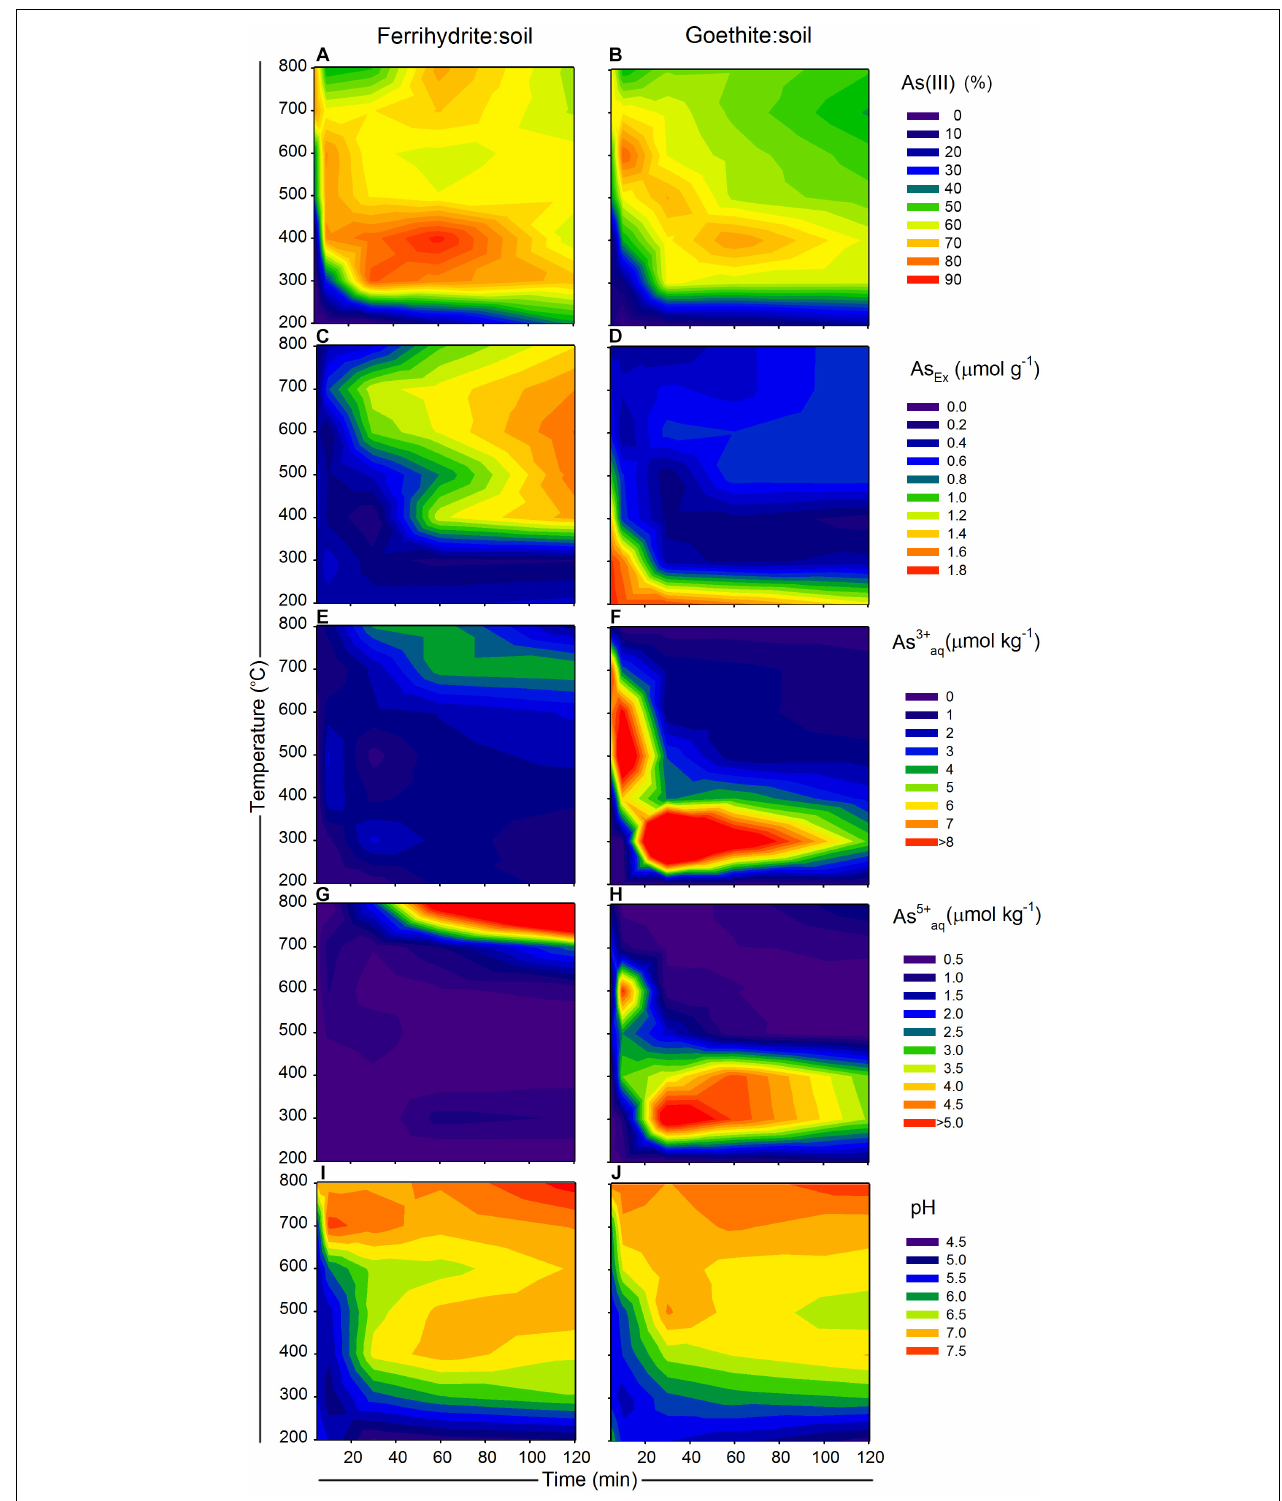
FIGURE 1 | Changes in As species and availability of ferrihydrite:soil and goethite:soil mixtures in relation to combustion time ( x -axis) and combustion temperature ( y -axis), where (A,B) solid-phase As(III) [excluding the transitory S-coordinated As species formed at 700 and 800 ◦ C], (C,D) As Ex , (E,F) water-extractable As 3 + aq , (G,H) water-extractable As 5 + aq and (I,J) pH (1:5 in water). Solid-phase As(III) determined by linear combination fits of As K-edge XANES spectra. Contour XYZ plots constructed using Sigma Plot v. 12.0.